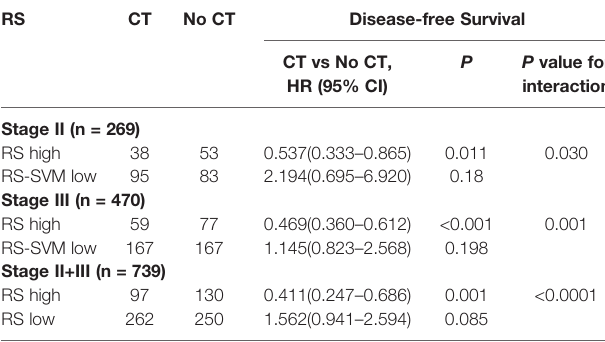
TABLE 3 | Treatment interaction with radiomics signature (RS) for DFS in patients with gastric cancer.